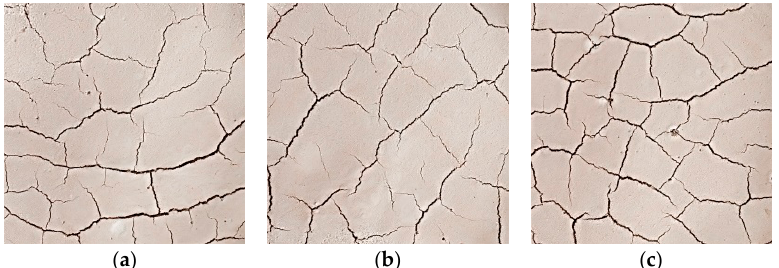
Figure 8. Improved soil fissure development morphology. ( a ) Group S10 specimens; ( b ) Group S11 specimens; ( c ) Group S12 specimens.